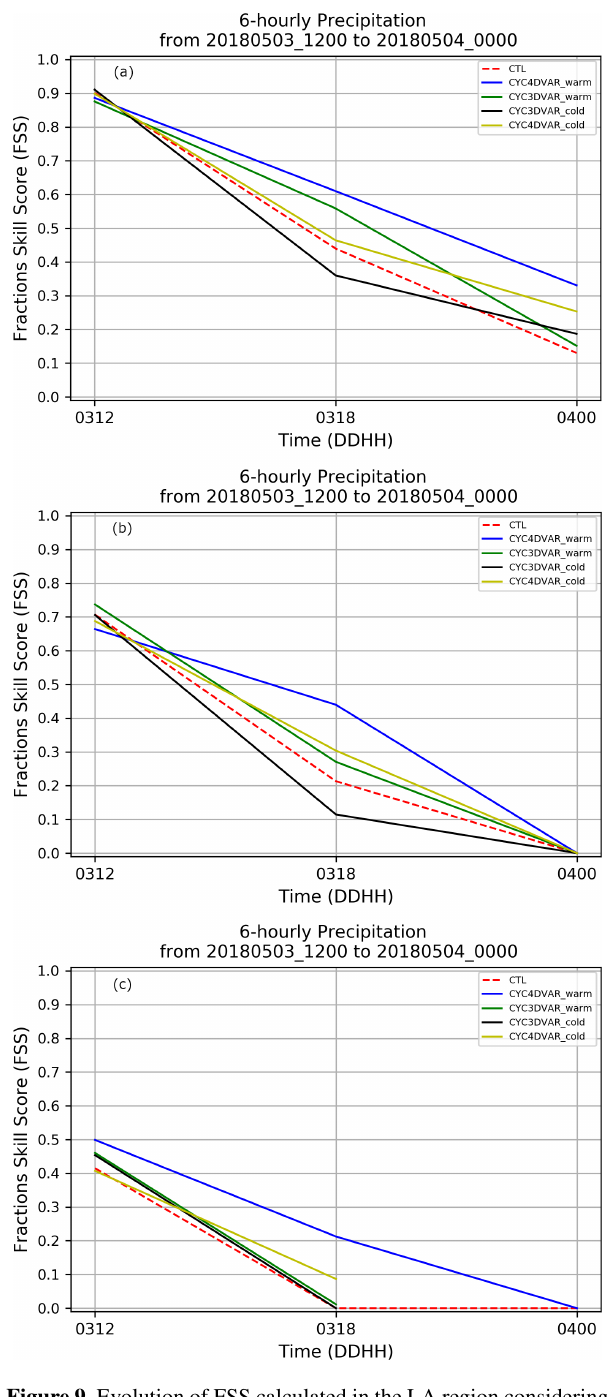
Figure 9. Evolution of FSS calculated in the LA region considering the 6-hourly accumulated precipitation for three threshold values: 10mm6h − 1 (a) , 15mm6h − 1 (b) and 25mm6h − 1 (c) . The dashed red line represents the CTL, the blue line CYC4DVAR_warm, the green line CYC3DVAR_warm, the black line the CYC3DVAR_cold and the yellow line